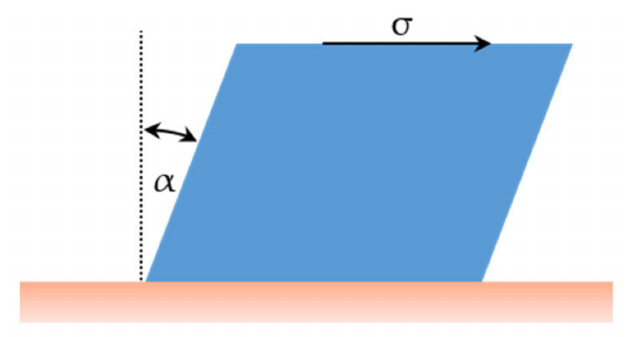
Figure 1. Quantities involved in viscosity